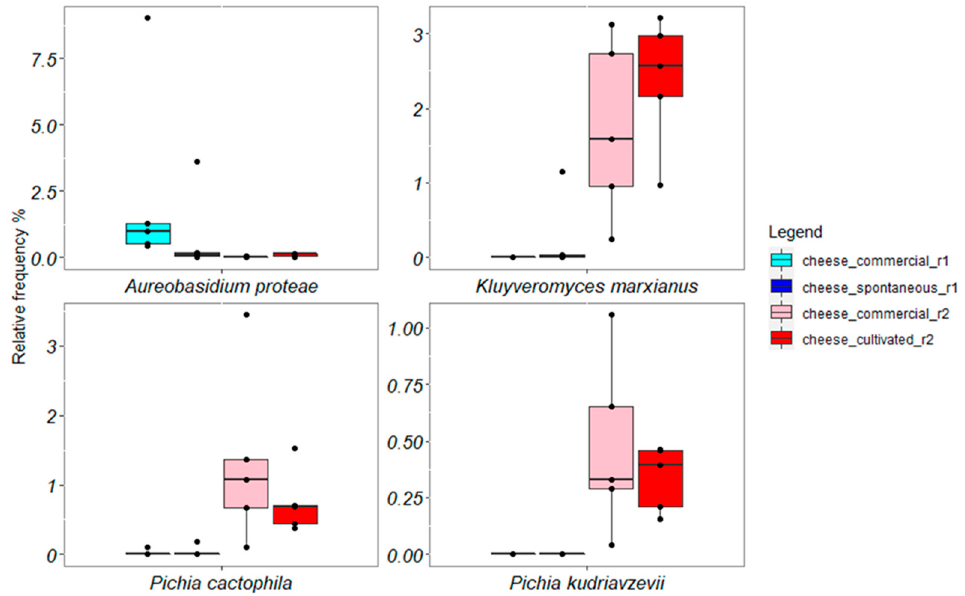
Figure 8. Boxplots showing relative frequencies of mycobiota differential ASVs evaluated through the Kruskal–Wallis test ( p -value < 0.05) in experimental Caciofiore